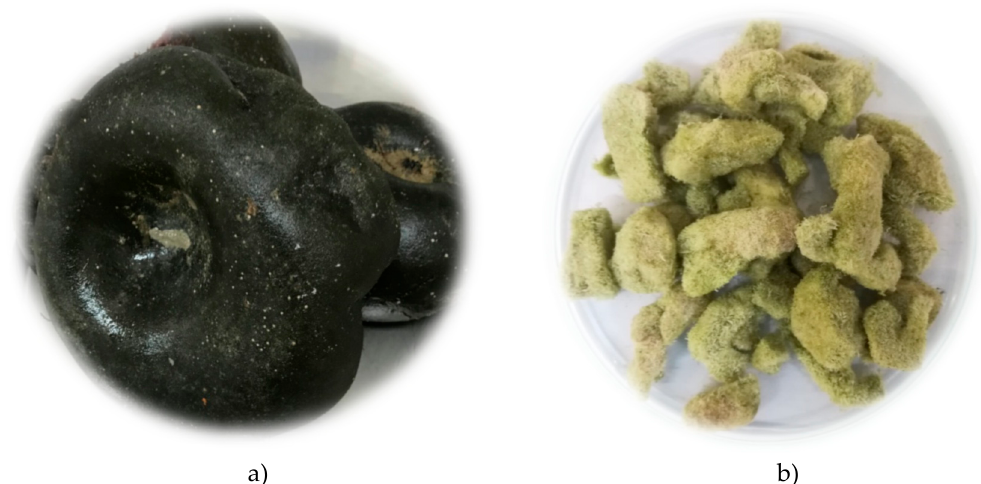
Figure 1. Codium bursa (Olivi) C. Agardh: a ) fresh sample (F-CB), b ) freeze-dried sample